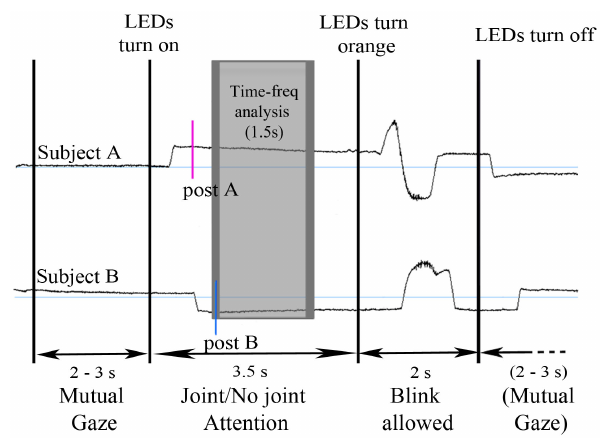
FIGURE 2 |Time course of an example trial illustrated on the vertical electrooculograms of a participant dyad. The upper and lower time courses represent the vertical EOGs of the subjects A and B of a given dyad. Every trial started by a period of mutual gaze for 2–3s.Then, two LEDs turned on (one in green, the other one in red) and both subjects moved their eyes to one LED, according to the directives for this block. After 3.5s, the LEDs turned orange and the subjects were allowed to blink. Post-saccade markers were manually inserted after the saccade onto the LED for both subject A (post A) and B (post B).The gray rectangle represents the time window of analysis; the dark gray border corresponds to the 300ms Blackman window used for the time-frequency transform, which was excluded from measurement, resulting in a 1.5s time window of analysis (shaded in light